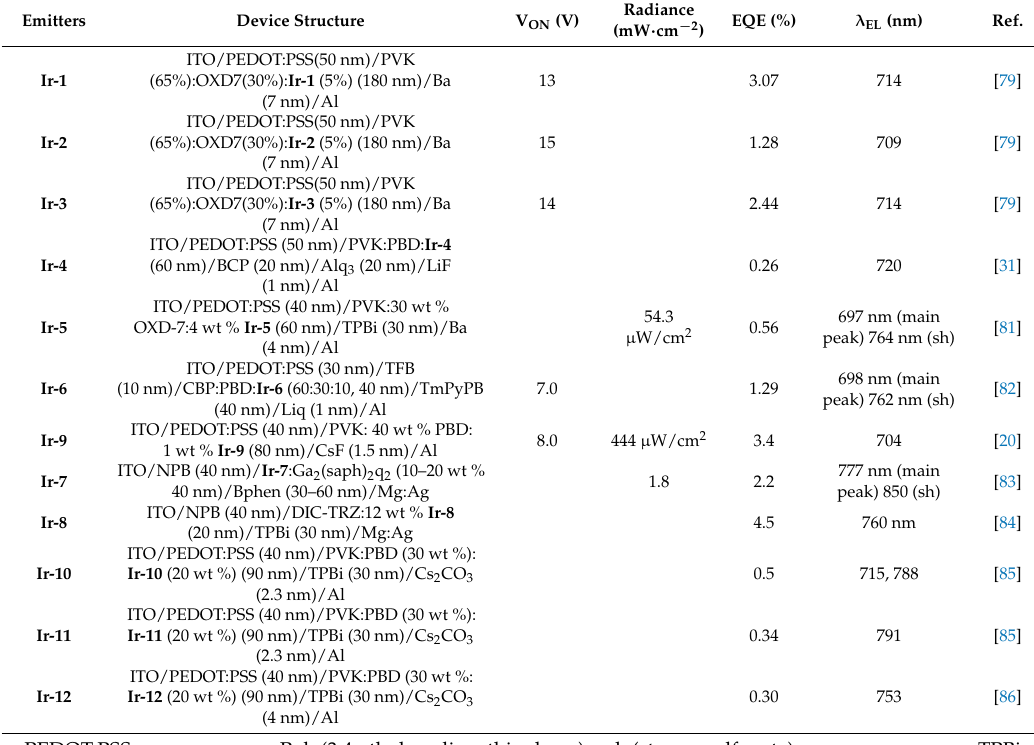
Table 2. Summary of electroluminescent properties of organic light-emitting diodes (OLEDs) fabricated with